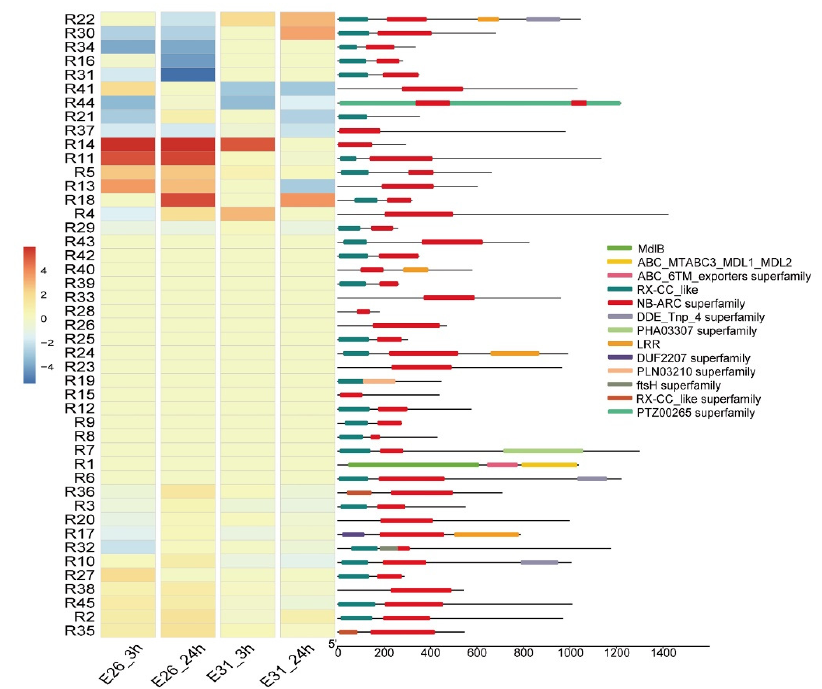
Figure 3. Gene expression patterns in response to powdery mildew infection and gene structures of the resistance gene analogs (RGAs) from 6VS of H. villosa . Left: The heatmap for the expression of predicted RGAs that treated with two Bgt isolates, E26 and E31, respectively at 3 and 24 h after inoculation. Right: The structure of resistance gene analogs which predicted from 6VS of H. villosa . Different colors represent different domains. The scale represents the length of amino acids of genes.